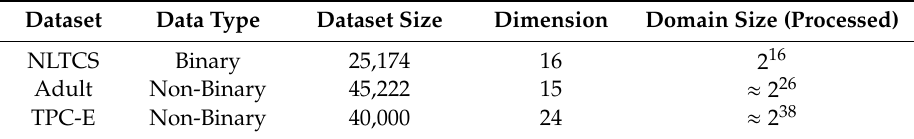
Table 2. Dataset information